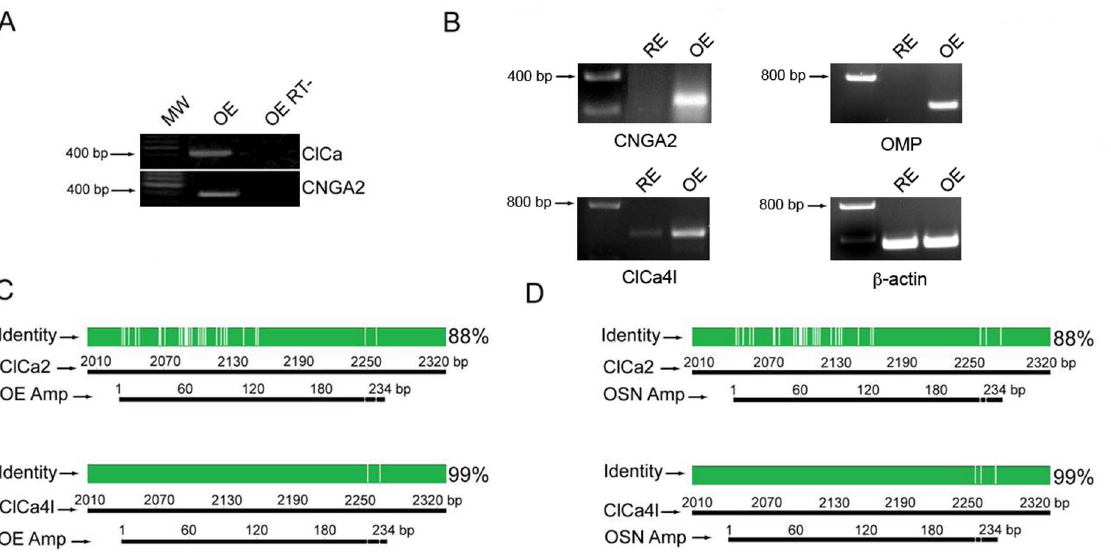
Figure 1. ClCa channel is expressed in rat olfactory sensory neurons. A. RT-PCR of rat olfactory epithelium (OE), using generic primers for ClCa4l and ClCa2 (ClCa). Positive control: CNGA2. OE RT-: Reverse transcriptase-free samples. MW: molecular weight marker (GeneRuler 100 bp plus DNA Ladder, Fermentas). B. RT-PCR from mRNA isolated from the olfactory (OE) and respiratory epithelia (RE). C. Alignment of ClCa amplicon of olfactory epithelium with ClCa2 and ClCa4l. Green denotes identity and white denotes difference in nucleotide sequence. D. Alignment of ClCa amplicon from an olfactory sensory neuron with ClCa2 and ClCa4l.